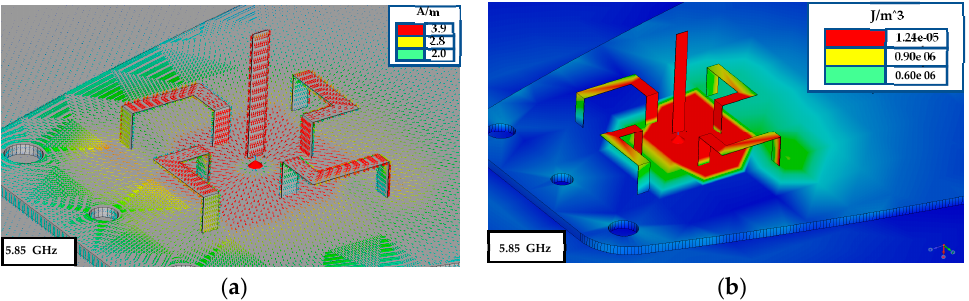
Figure 3. ( a ) Surface current; and ( b ) Magnetic field distribution obtained from the monopole WAVE antenna with quadruple closed-loop device.